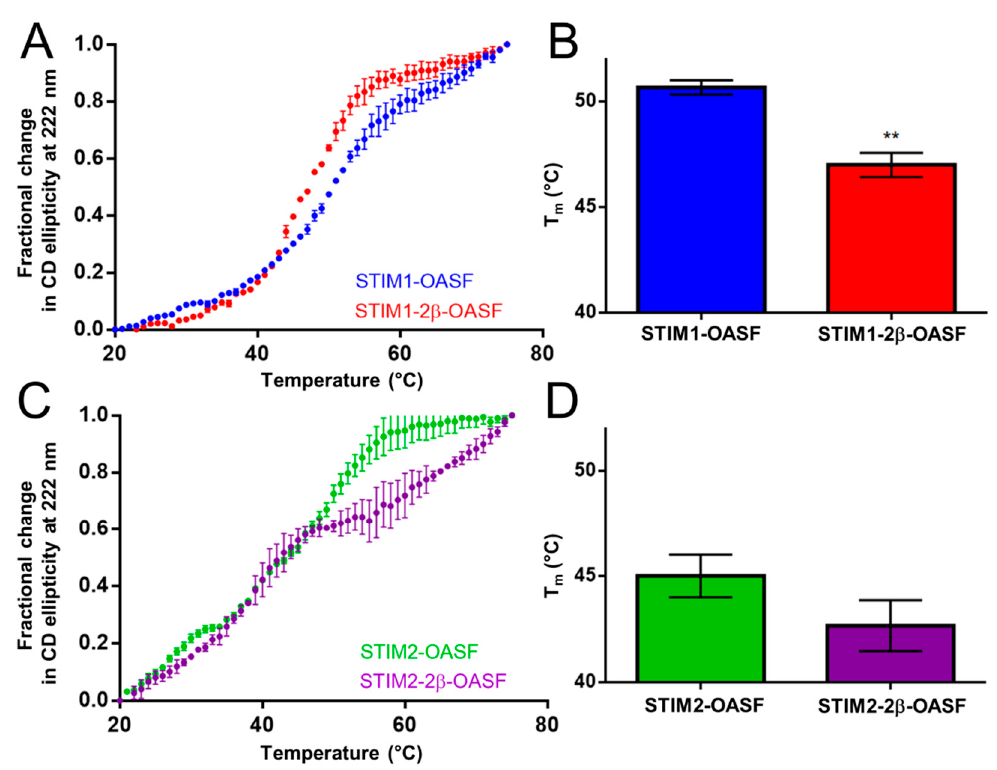
Figure 3. Thermal stability of STIM OASF proteins. ( A ) Thermal unfolding profile of STIM1-OASF and STIM1-2 β -OASF. ( B ) Comparison of the STIM1-OASF and STIM1-2 β -OASF T m extracted from the thermal melts. ( C ) Thermal unfolding profile of STIM2-OASF and STIM2-2 β -OASF. ( D ) Comparison of the STIM2-OASF and STIM2-2 β -OASF T m extracted from the thermal melts. Thermal melts were acquired using 0.2 mg · mL − 1 protein. Data are means ± SEM of n = 3 separate protein purifications. In ( B ), ** p < 0.01 using Student’s t -test.